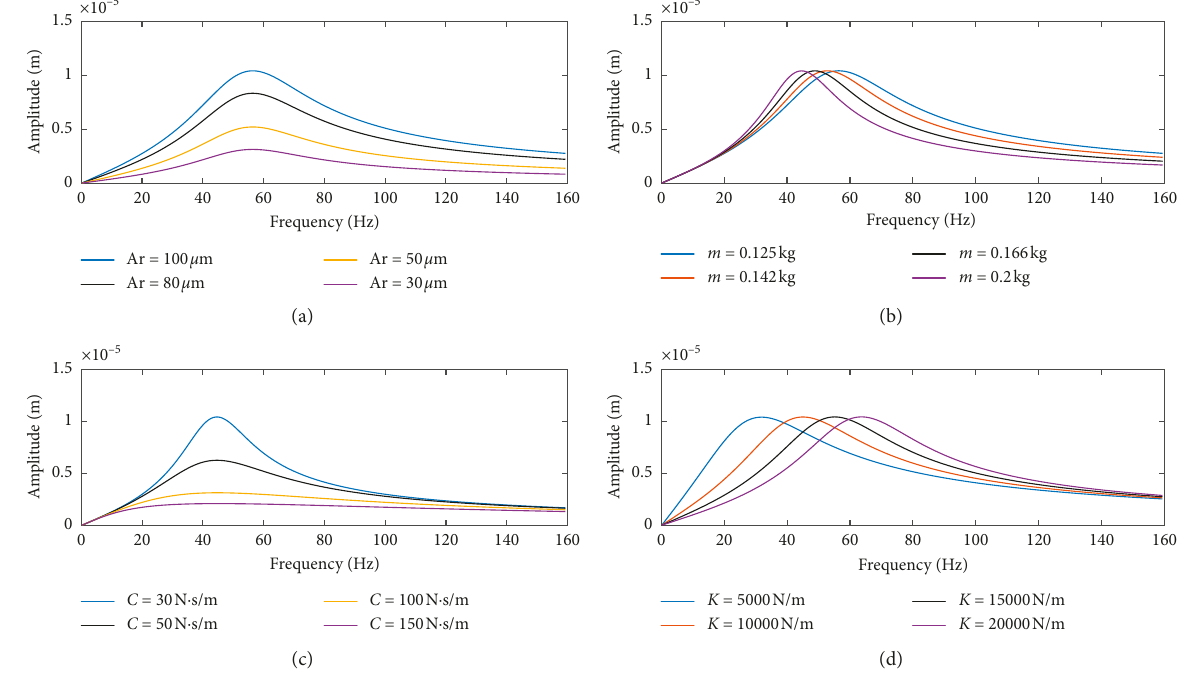
Figure 2: Analysis of influencing factors of linear operation stationary rings displacement: (a) effect of axial excitation amplitude on displacement; (b) effect of stationary ring mass on displacement; (c) effect of axial damping on displacement; (d) effect of linear stiffness on displacement.